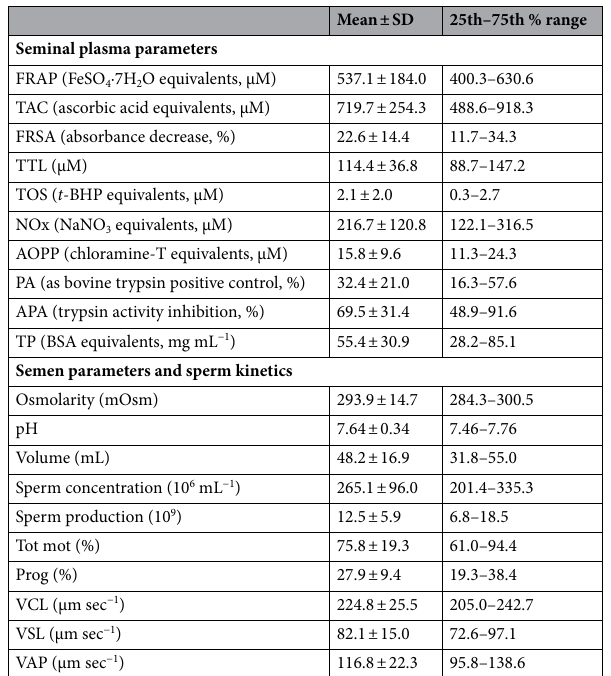
Table 1. Mean (± SD) values and 25th–75th range of seminal plasma oxidative profile and proteolysis regulator parameters, semen parameters and sperm kinetics in normospermic donkey stallions (n = 9). FRAP: ferric reducing ability of plasma; TAC: total antioxidant capacity; FRSA: free radical scavenging activity; TTL: total thiol levels; TOS: total oxidant status; NOx: nitric oxide metabolites; AOPP: advanced oxidation protein products; PA: protease activity; APA: antiprotease activity; TP: total protein; Tot mot: total sperm motility; Prog: progressive sperm motility; VCL: curvilinear velocity; VSL: straight-line velocity; VAP: average path velocity.